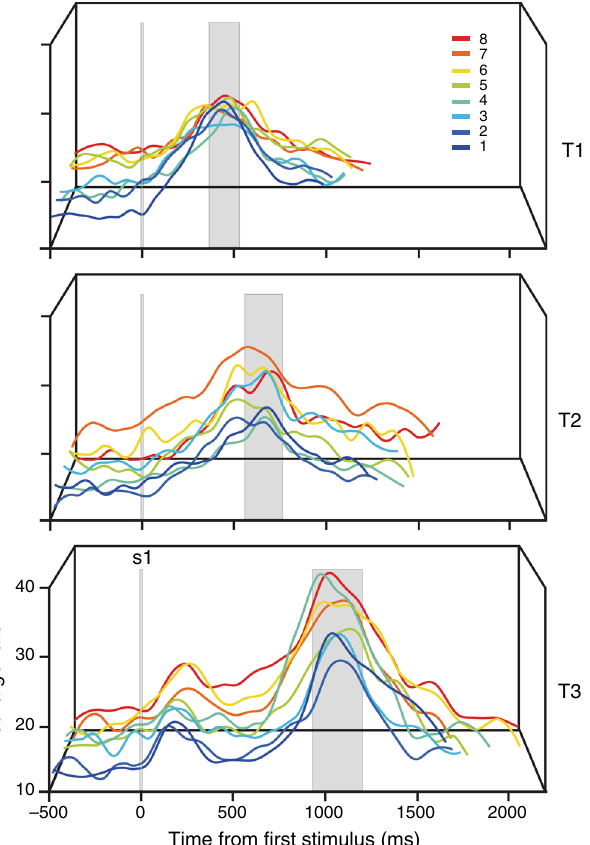
Fig. 5 Mean activity of the population of boundary neurons for the three blocks of the categorization task (T1, T2, and T3). The color code corresponds to the eight test intervals as indicated in the inset. The vertical line indicates the presentation of the fi rst stimulus (s1). The vertical rectangle indicates the mean ( + 1 SD) time to peak activity from fi rst stimulus computed from the Gaussian distributions of Fig.